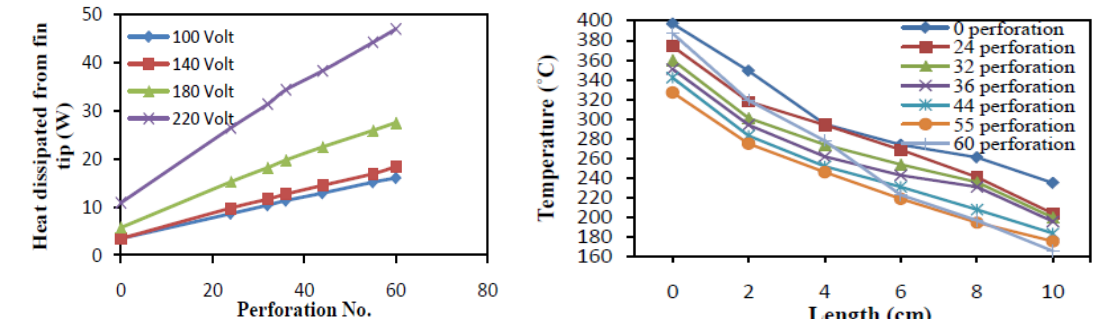
Figure 8: Effect of Perforation No. on Heat Transfer Front the Fin Tip at varying Voltage and Effect of length on temperature distribution for varying perforations at constant voltage (220V)